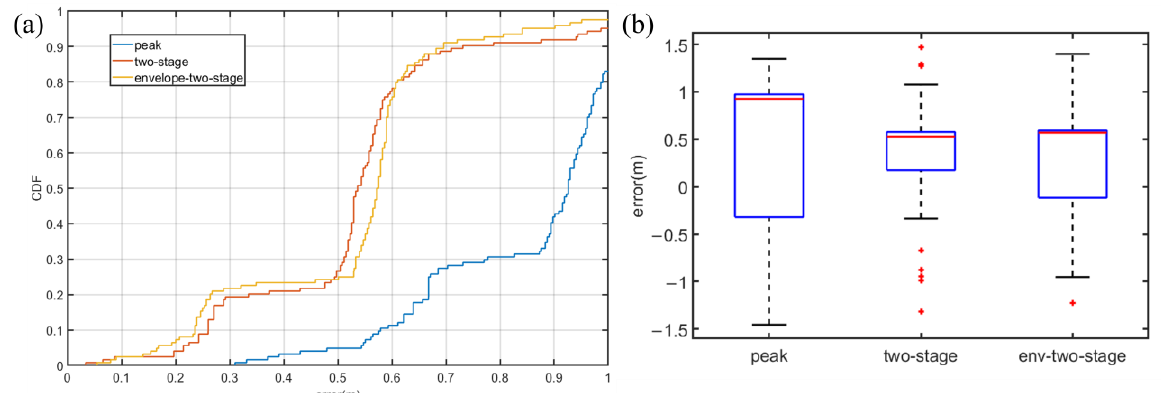
Figure 27. Signal propagation characteristics in case 3. ( a ) Signal Spectrum and ( b ) correlation results.